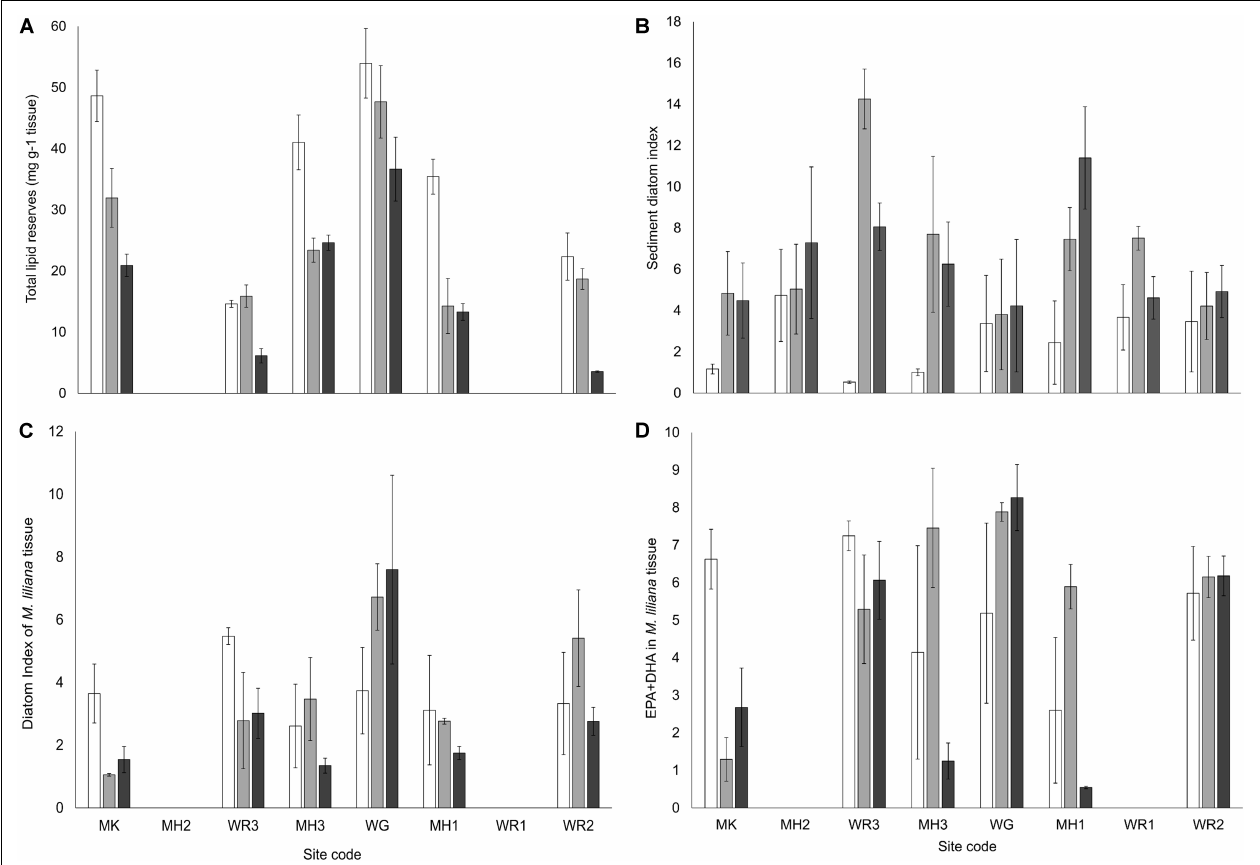
FIGURE 9 | (A) Mean total lipid reserves (mg g - 1 DW tissue, ± SE, n = 3) from homogenized M. liliana specimens (3 individuals per sample, mean shell length 25 ± 4mm) across all sites and nutrient treatments. (B) Mean ratio of ω 3: ω 6 PUFAs from composite M. liliana tissue as a function of site and nutrient enrichment treatment. (C) Mean diatom index [16:1 ω 7 + 20:5 ω 3]/[18:1 ω 9 + 18:4 ω 3 + 22:6 ω 3] from composite M. liliana tissue. (D) Mean proportion of EPA [20:5 ω 3] + DHA [22:6 ω 3], extracted from composite M. liliana tissue (3 + individuals per 50 mg composite sample, ± SE, n = 3). Nutrient treatments; white bars – control plots (0 g N m - 2 addition), light gray – medium plots (150 g N m - 2 addition), dark gray – high plots (600 g N m - 2